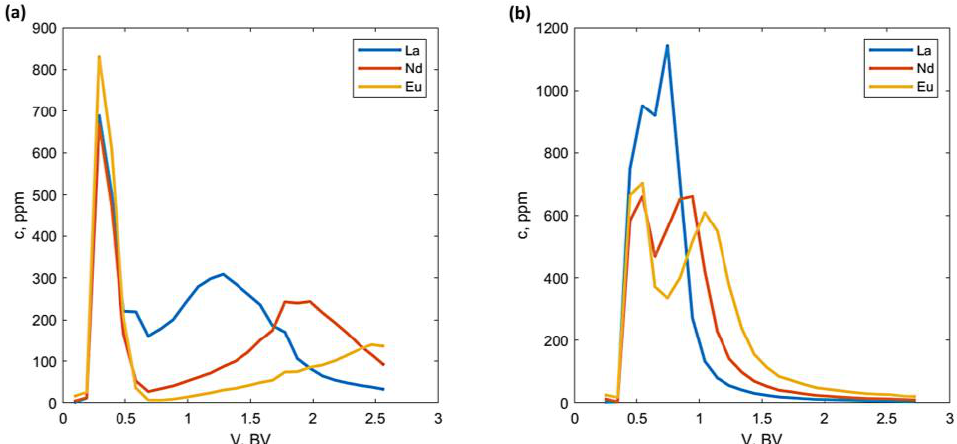
Figure 6. Effect of HCl concentration in the eluent on the retention behavior of REEs on IRA-410: ( a ) 10 mM HCl; ( b ) 50 mM HCl (flowrate = 2.98 BV/h; feed solution = #2; feed volume = 0.05 BV).